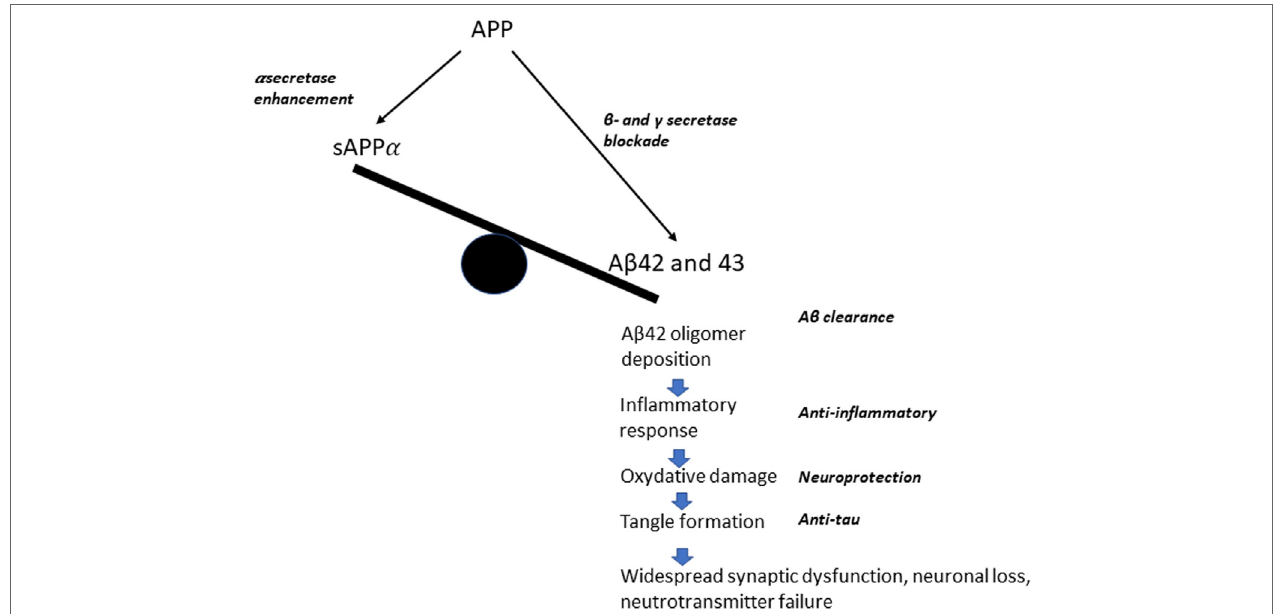
FiGURe 1 | A simplified diagram of the possible therapeutic approaches, according to the amyloid cascade